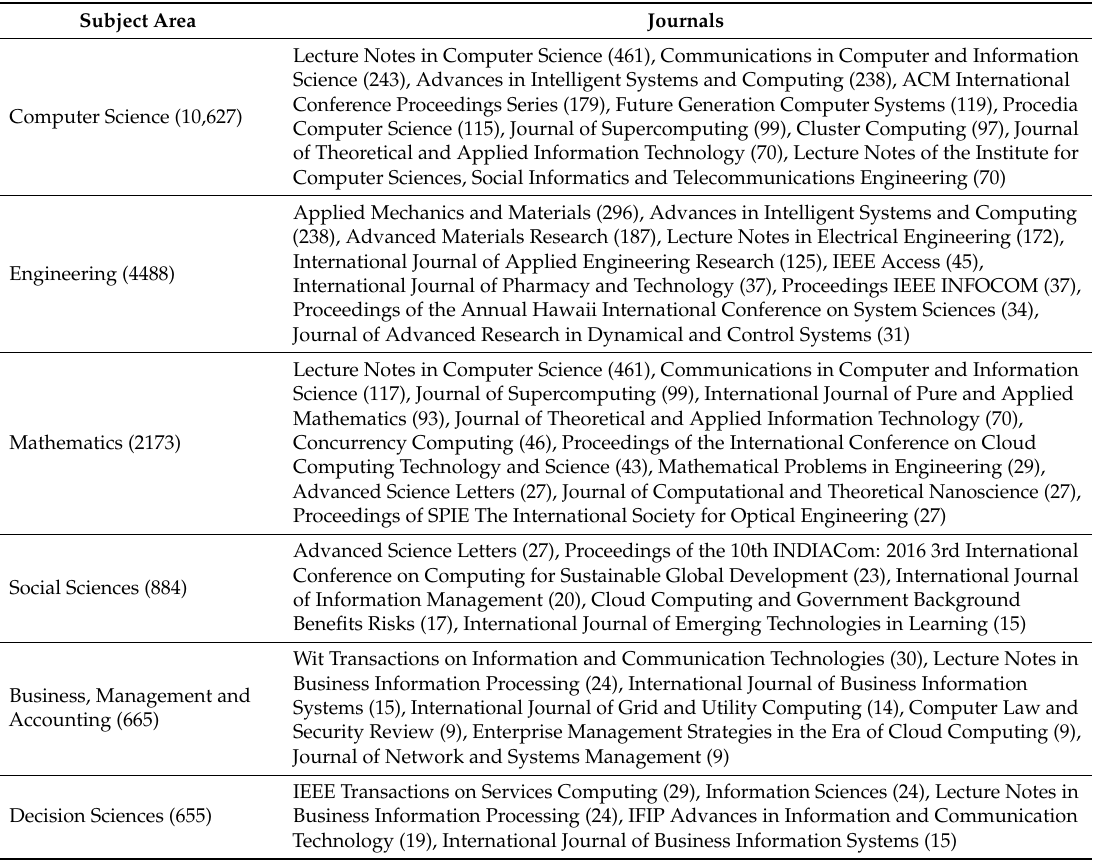
Table 5. Top most productive source titles in research on cloud computing by a subject